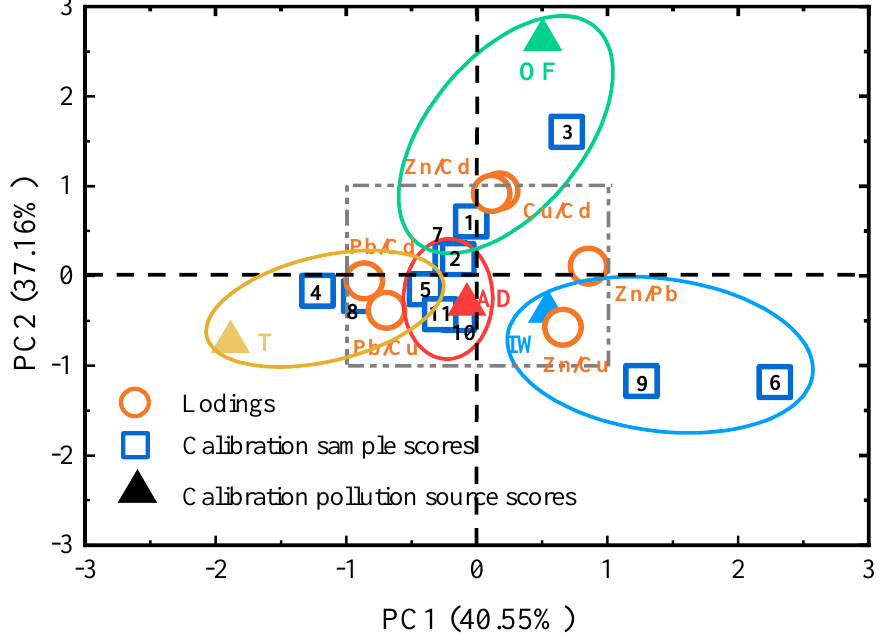
Figure 5. Correlations between the ratios of heavy metals and the first two principal components (PC1 and PC2) and a biplot of the ratios of heavy metals, sampling sites, and pollution sources (OF = organic fertilizer, T = tailings, IW = irrigation water, and AD = atmospheric deposition), according to the ratio of heavy metals accumulated in the latter.